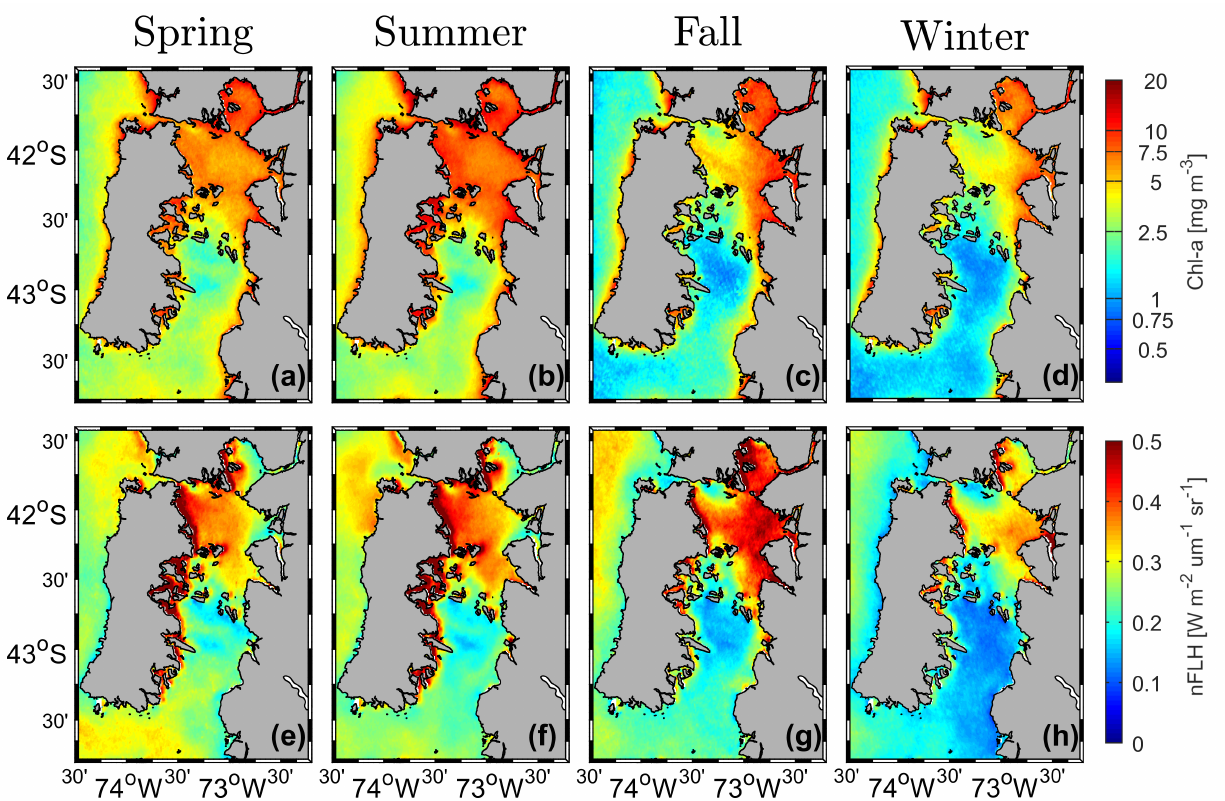
Figure 3. Seasonal climatologies of (upper panels) Chl-a and (lower panels) nFLH computed from all daily MODIS-Aqua images (2003–2019) for ( a , e ) spring (October, November, December), ( b , f ) summer (January, February, March), ( c , g ) fall (April, May, Jun), and ( d , h ) winter (July, August, September). For reference of locations, see Figure